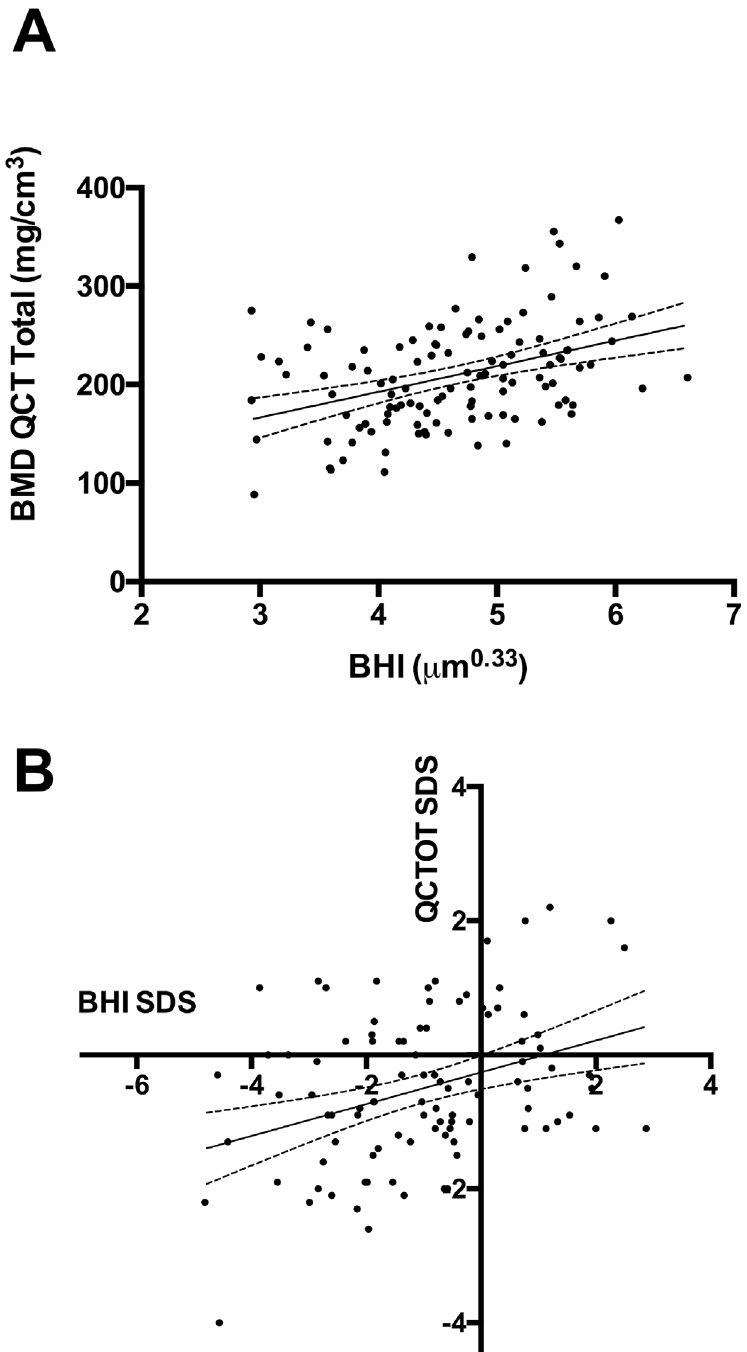
Fig 2. Positive association of BMD values obtained via BoneXpert and pQCT (XCT 900 Stratec 1 ). A) BHI readings obtained using BoneXpert showed a positive correlation with BMD readings at the distal radius as measured via pQCT (XCT 900 Stratec 1 ; r = 0.39; P < 0.0001). B) Accordingly, the SDS of the pQCT method (QCTOT SDS total, vertical axis) and the BoneXpert (BHI SDS, horizontal axis) were positively correlated (r = 0.3; P = 0.003). The predicted values based on bivariate regression analysis are indicated as a solid line. The dashed lines represent the 95% confidence interval.